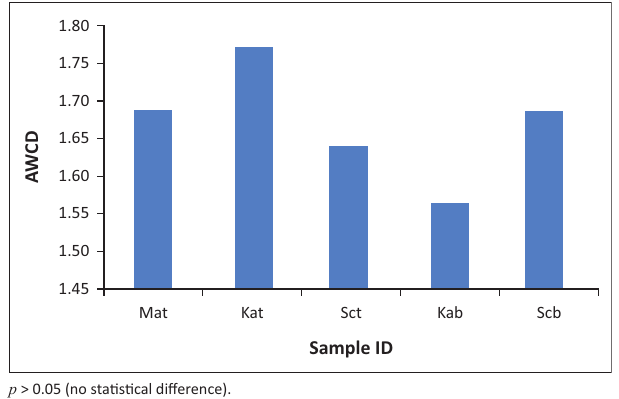
FIG URE 2: Carbon substrate utilisation activity as average well colour development by the rhizosphere microbial